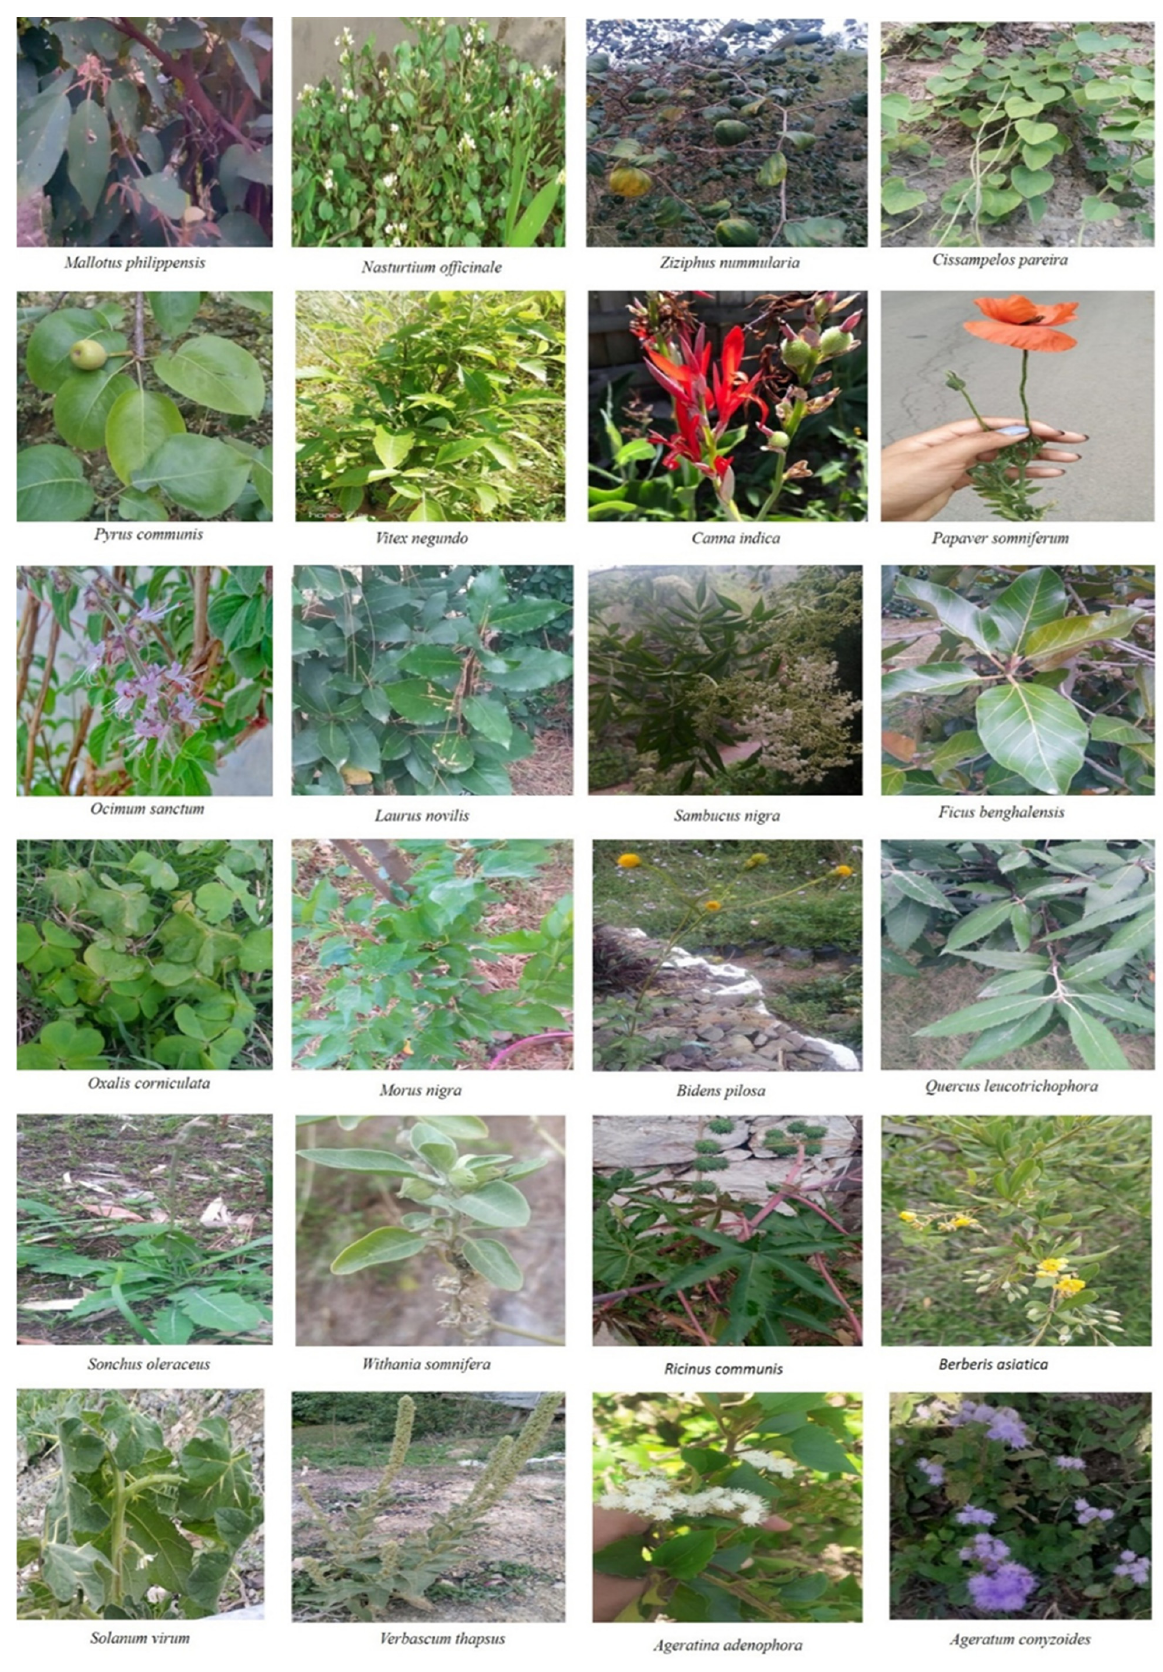
Figure 3. Pictures of medicinal plants surveyed in the current study.